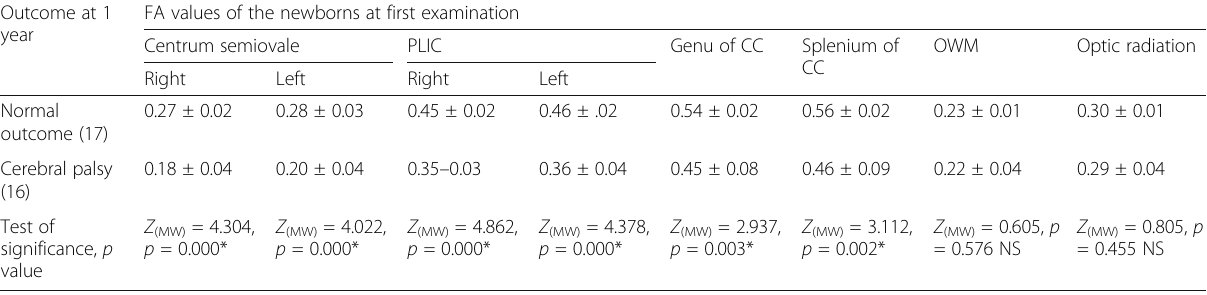
*Statistically significant ( p <